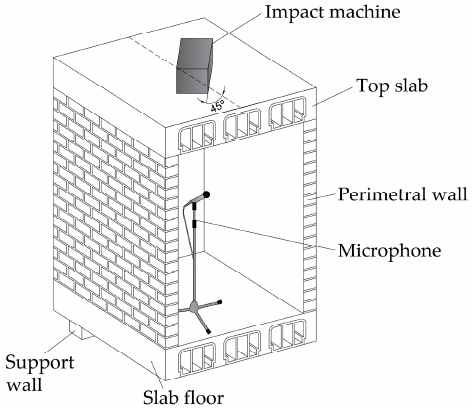
Figure 8. Measurement of the impact sound insulation.